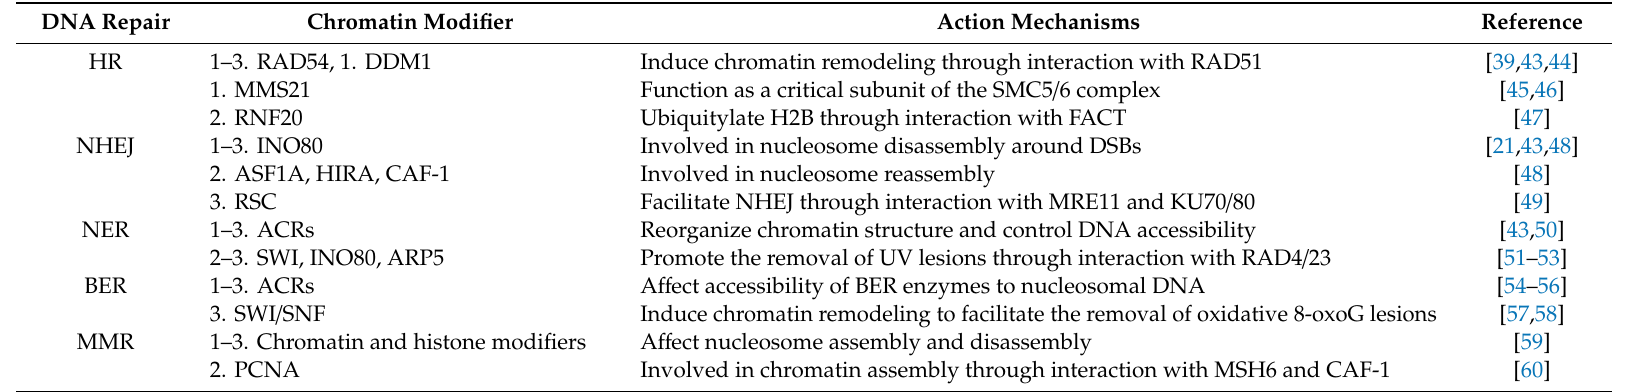
Table 1. DNA repair mechanisms associated with chromatin remodeling in eukaryotic cells. 1. Arabidopsis , 2. human or mammalian, and 3.